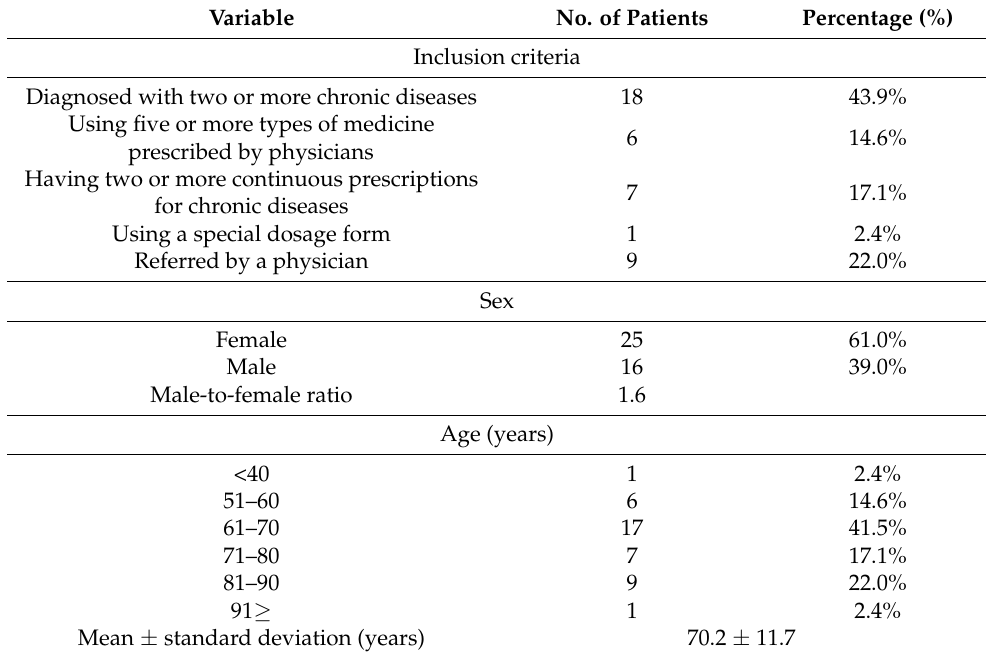
Table 5. Demographic information of the patients receiving cognitive services ( N =